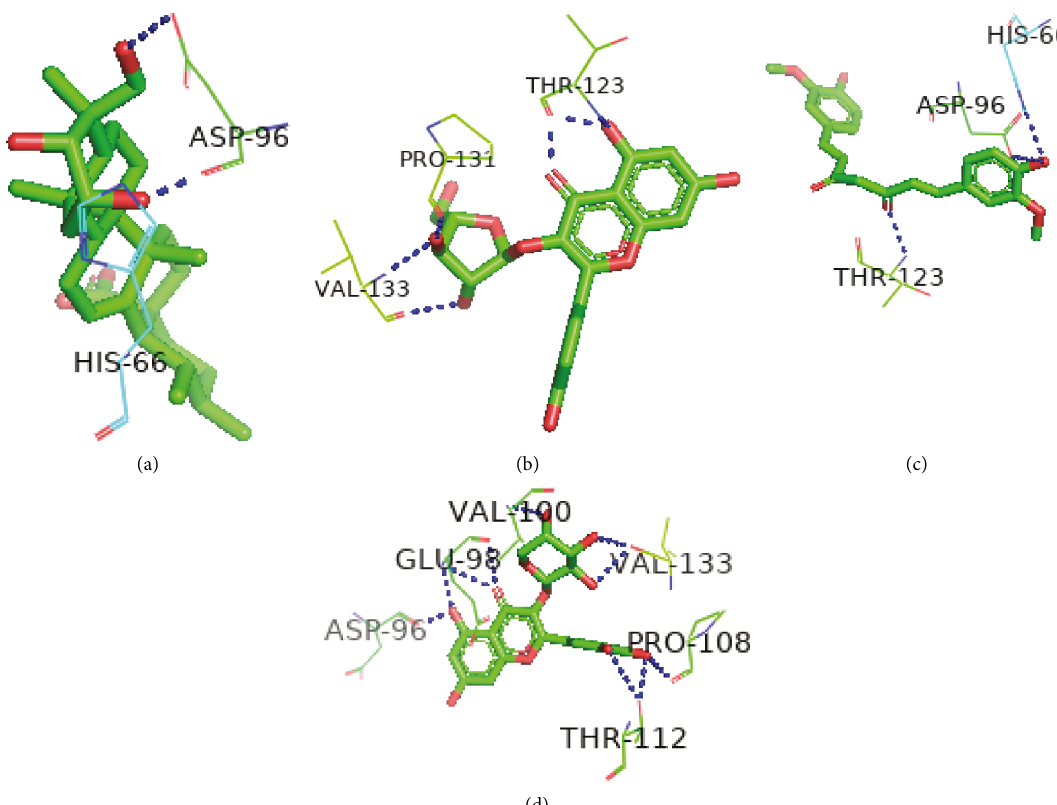
Figure 7: Polar binding sites of P48 with (a) Asiatic acid, (b) avicularin, (c) curcumin, and (d)